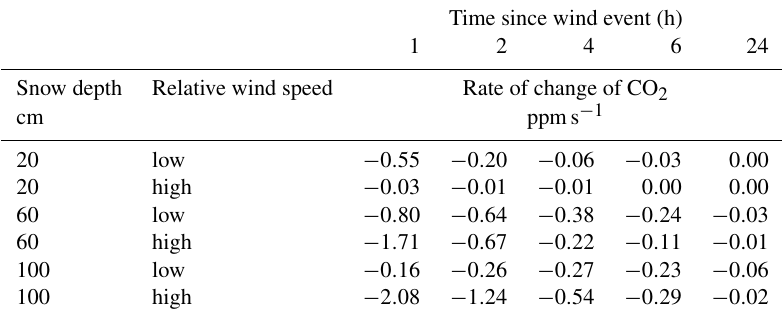
Table 3. Summary table of change in modelled CO 2 concentration per second at 1, 2, 4, 6, and 24h since the wind event (step change in modelled snowpack diffusivity) at the topmost layer in the model. Snow depths of 20, 60, and 100cm are shown, along with lowest and highest simulated wind